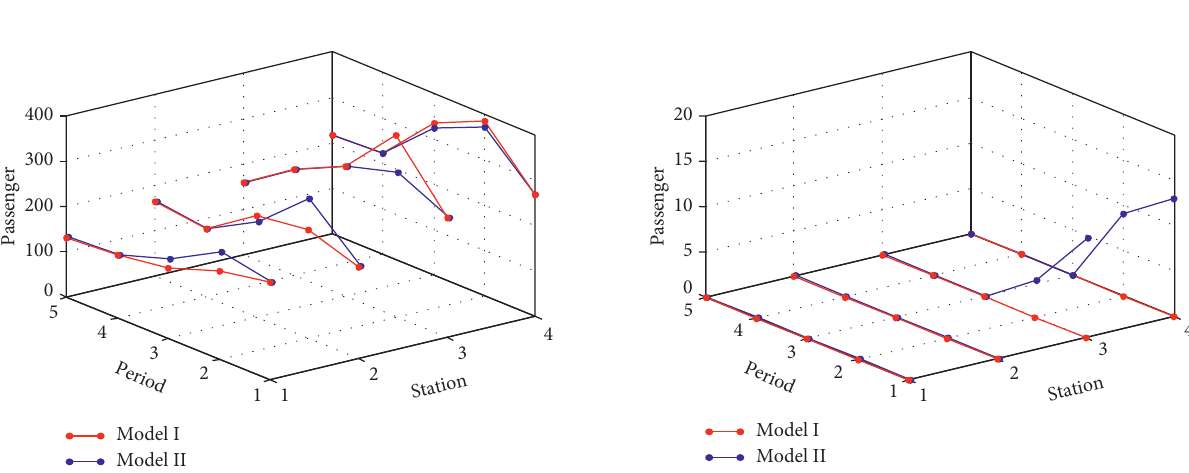
Figure 10: Comparison of left-behind passengers at the platform in two